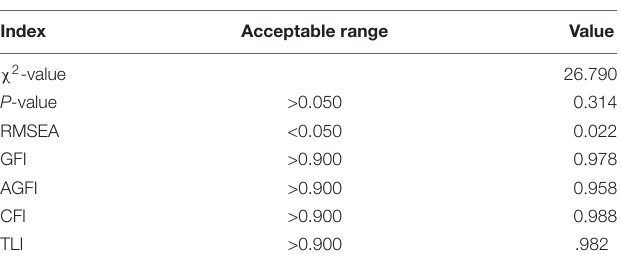
TABLE 4 | Model fit